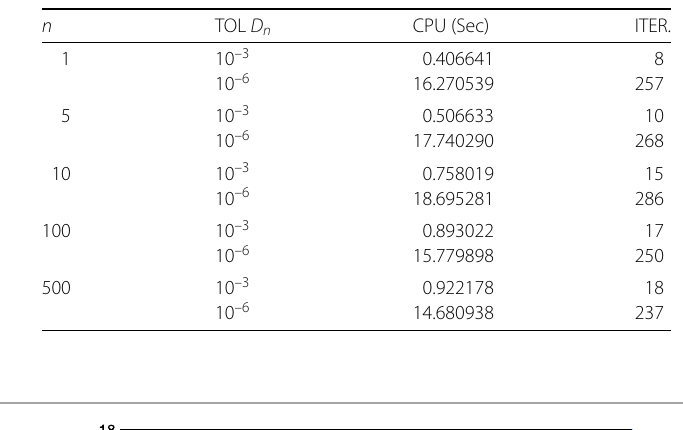
Table 1 Numerical results for Algorithm 4.1